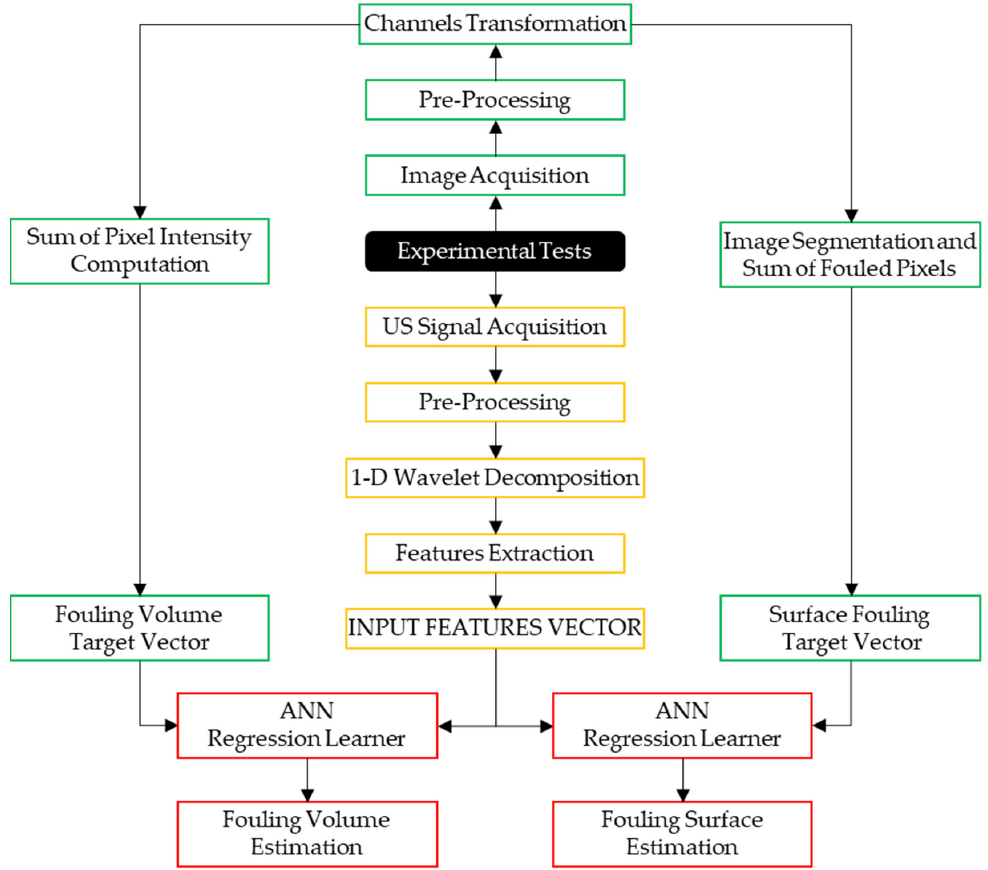
Figure 2 . Data acquisition and processing flow chart. Figure 2. Data acquisition and processing flow